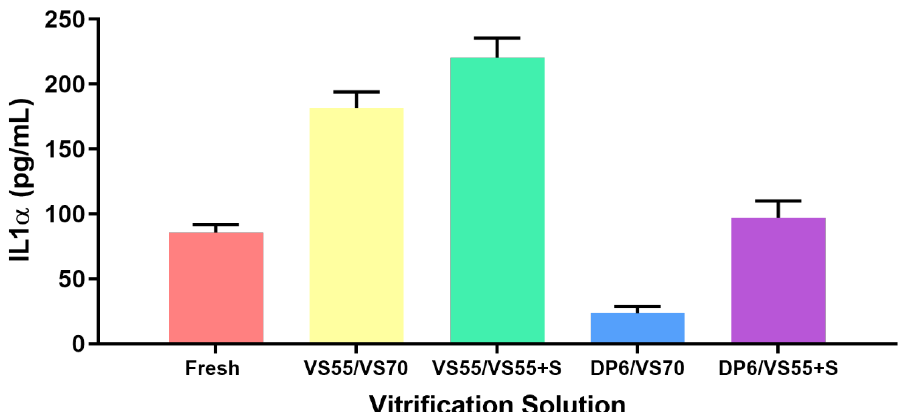
Figure 7. Comparison of IL-1 α release for fresh and vitrified EpiDerm constructs. Constructs were loaded and vitrified with the indicated solution combinations. Upon rewarming the supernatants from each construct were retained and IL-1 α was measured by ELISA. Values are the mean ( ± SEM) of ≥ 3 replicates. Statistical analysis performed by one-way ANOVA and Tukey’s multiple comparison test one-way ANOVA with Tukeys multiple comparison test.